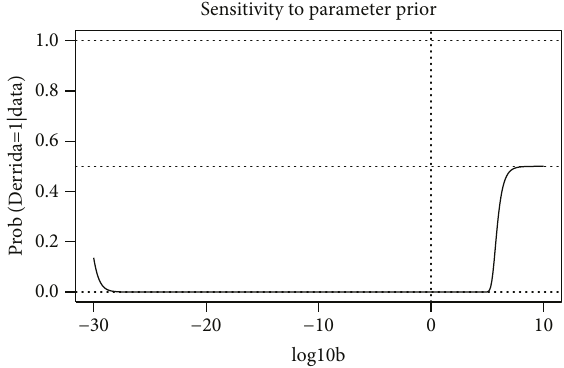
Figure 8: Posterior probability of criticality ( λ = 1 ) as a function of prior conditional precision (inverse of prior conditional variance) given λ ≠ 1